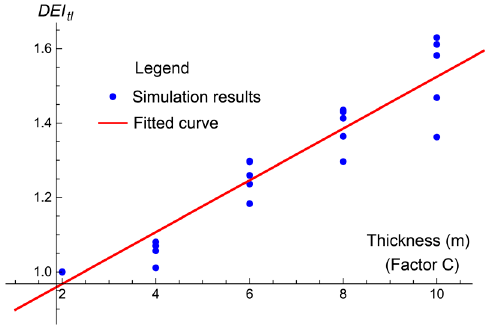
Figure 9. The relationship between the DEI tl and the thickness (Factor C) of the coalface.